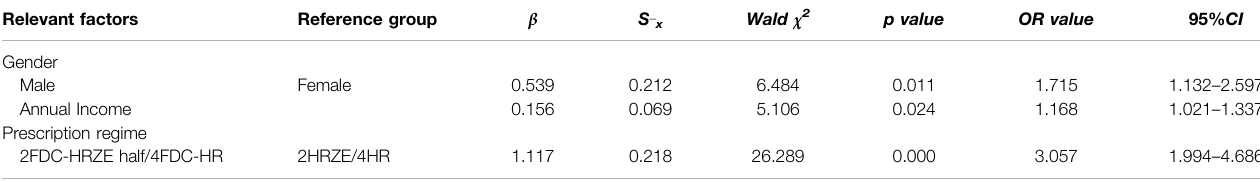
TABLE 7 | Multivariate analysis of risk factors of positive cases. Relevant factors